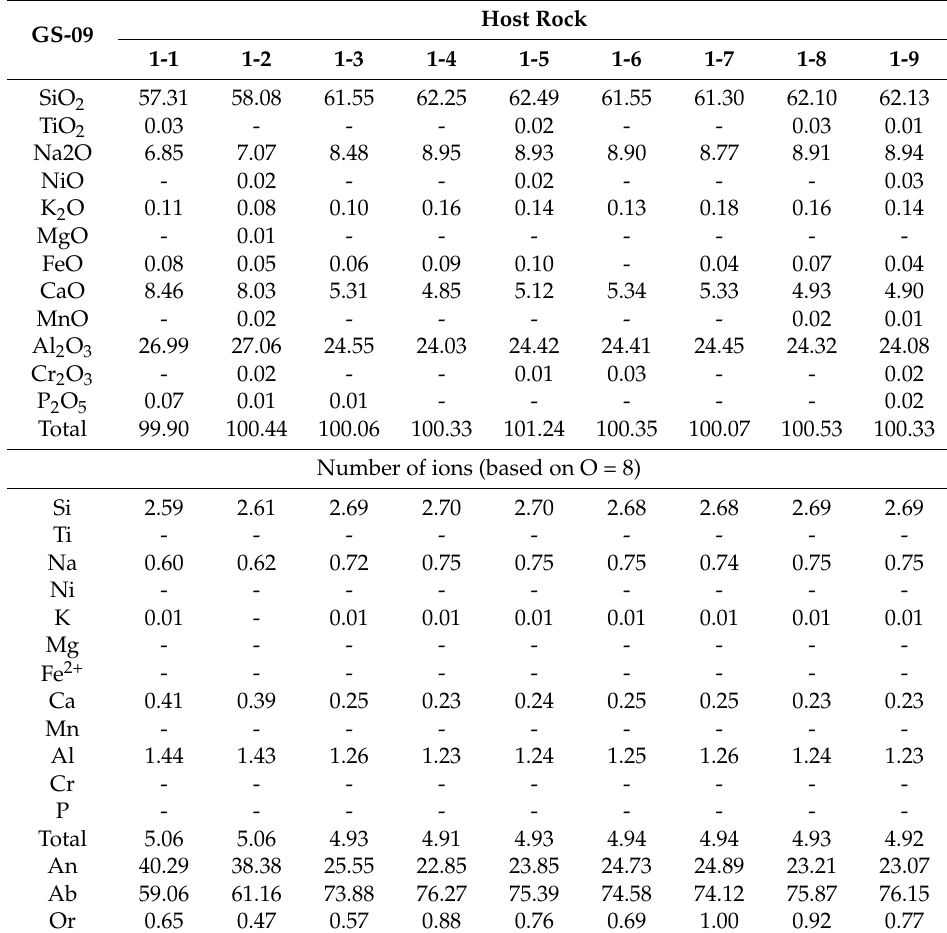
Table 1. Results of EPMA analyses of plagioclase crystals in the host rock of the Qingshanbao complex (wt